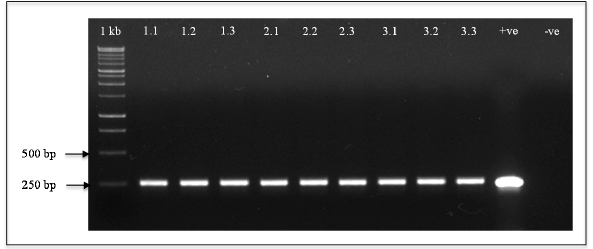
Figure 2. Detection of the yefM Spn antitoxin in transformed Arabidopsis thaliana . Extracted DNA from transformed plants of three different T 2 lines was used as the template for PCR (Lanes 1.1 – 1.3 : transgenic Line 1; Lanes 2.1 – 2.3 : transgenic Line 2; Lanes 3.1 – 3.3 : transgenic Line 3) using yefM Spn -specific primers. Lane +ve : pMDC160_ yefM Spn as the positive control. Lane –ve : wild-type A. thaliana Col 0 as the negative control. 1 kb: 1-kb DNA ladder (Fermentas). Molecular sizes are indicated.